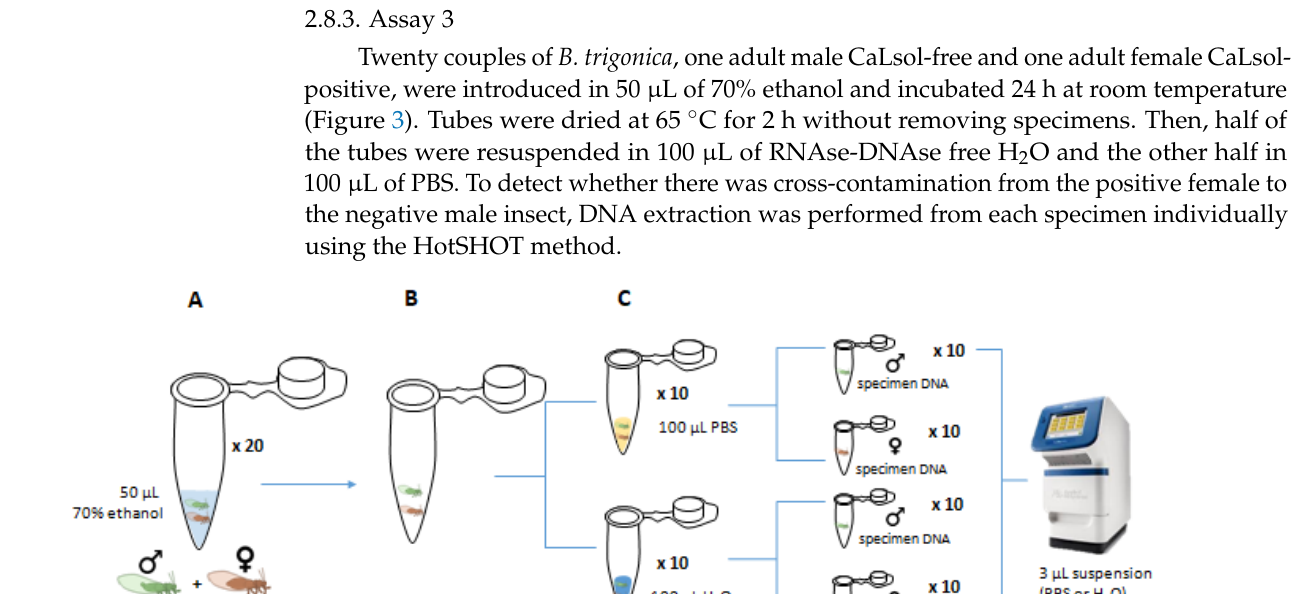
Figure 2. Cross-contamination study: Assay 2. Couples of same sex psyllids, one CaLsol-positive and one CaLsol-free, were incubated in ethanol ( A ). Ethanol was dried without removing the specimens ( B ). The samples were resuspended in water or PBS before direct qPCR analysis ( C ). ♀: female; ♂: male.